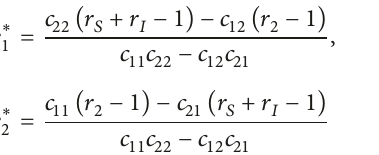
Figure 3: Asymptotic behavior cases (Theorem 6) of the solutions of system (17) for parameters values 𝑏 1 fl 𝑏 1 𝑆 = 𝑏 1 𝐼 > 1 , 𝑏 2 = 5 , 𝑐 𝑆𝑆 = 3 , 𝑐 = 2.8 , 𝑐 = 𝑐 = 𝑐 = 𝑐 = 𝑐 = 1 , 𝑐 = 2 , 𝑐 = 1.8 , and 𝑆𝐼 𝑆2 𝐼𝑆 𝐼𝐼 𝐼2 22 2𝑆 2𝐼 ] ∈ (0, 1]